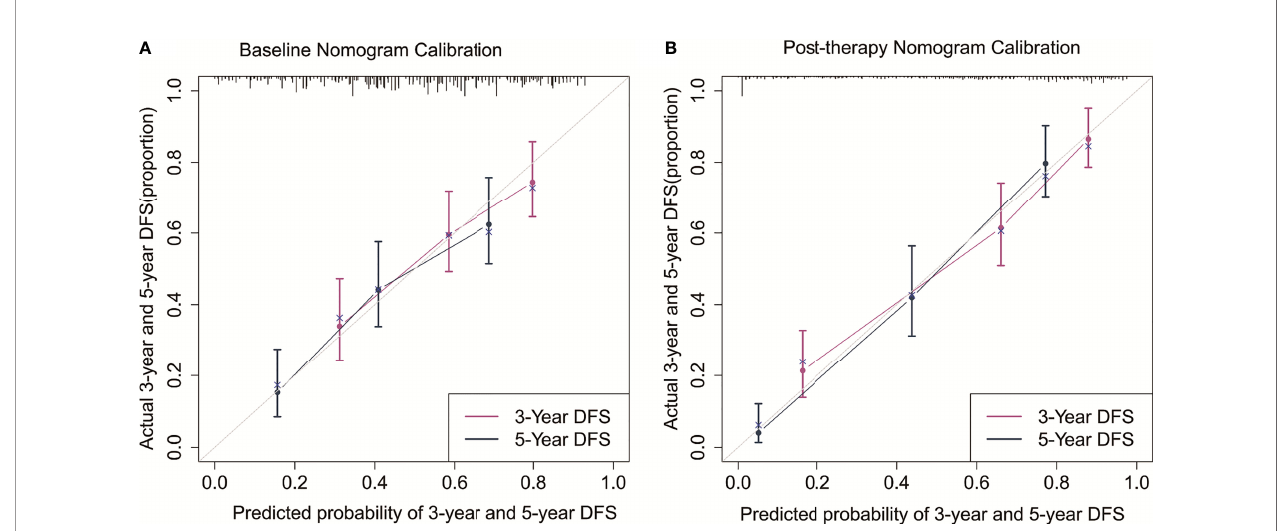
FIGURE 4 | Calibration curves for the baseline nomogram (A) and post-therapy nomogram (B) predicted 3- and 5-year